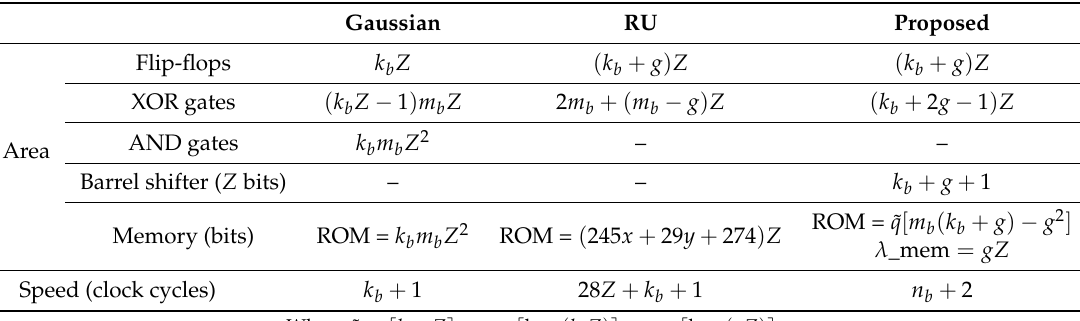
Table 5. Comparison between Gaussian method, RU method, and proposed method.